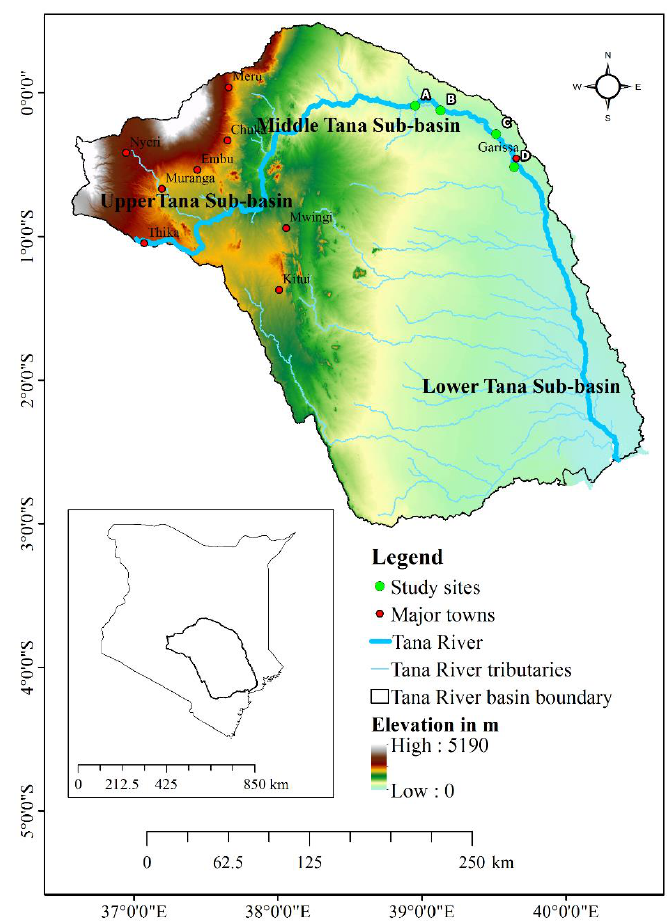
Figure 1. Satellite image showing the Tana River reach under study and the Digital Elevation Model of the basin. The Kenya and Tana River Basin boundaries are shown in the side map and selected sites for detailed study on river channel changes are labelled as sites A, B, C, and D, as shown in the map. At the upper sub-basin, the soil is mainly volcanic, and the annual rainfall is high, making it suitable for rain-fed agriculture. This is an area where water resources are mainly used for agricultural irrigation, industrial (mainly through inter-basin water transfer) and hydropower. The Seven Forks hydropower schemes which provide about 567 MW [29] were built between 1968 and 1988 along the Tana River and form a cascade of five dams from upstream to downstream namely: Masinga, Kamburu, Gitaru, Kindaruma, and Kiambere dams within the sub-basin. Out of these, only Masinga and Kiambere, built in 1981 and 1988 respectively, represent significantly large reservoirs that can alter the Tana River hydrological regime, sediment transport and the magnitude and incidence of floods in the Middle and Lower Tana [28]. The other three are small reservoirs that cannot essentially regulate the Tana River [32]. The middle Tana sub-basin has humid to semi-arid conditions and its altitude rapidly decreases from 1000 m to 200 m above sea level. The soil is mainly composed of cambisols and alkaline rocks that can